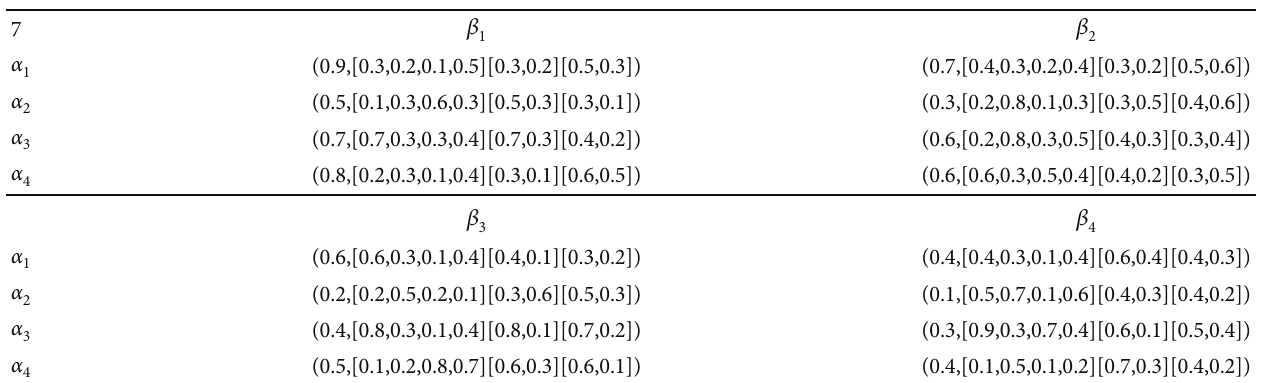
Table 7: Decision matrix of expert -7 (H 7 ).